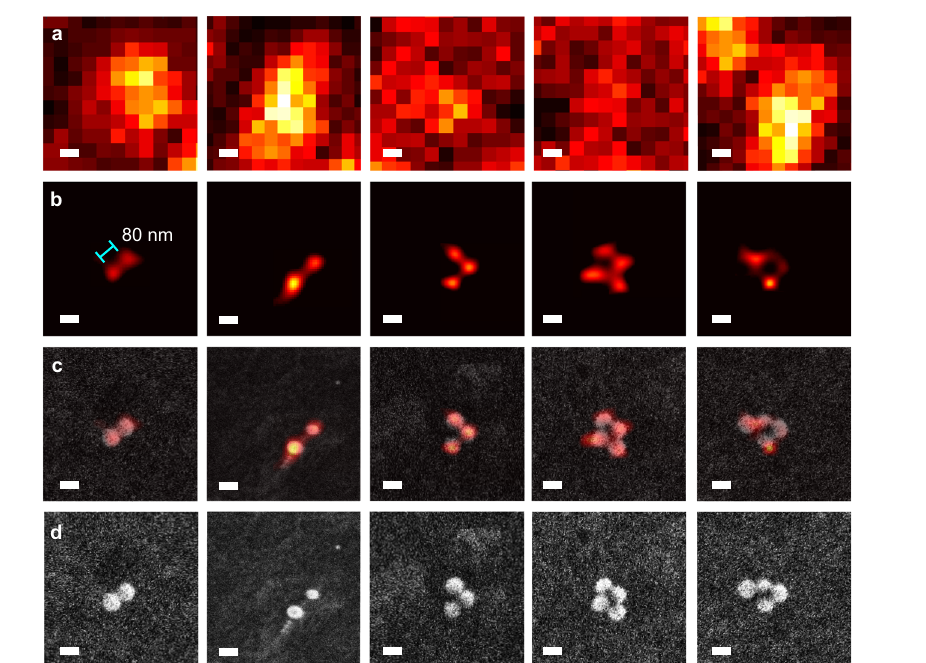
Fig.4|HMESnanoscopyimagesof80-nmpolystyrenebeads.a Averagedpartial scattering images. Total 240 partial scattering images were generated from 12 different azimuthal angular illuminations ( ϕ ranging from 0° to 330° with an interval of 30°) with 20 varying speckle illumination patterns at θ =60°. b Super-